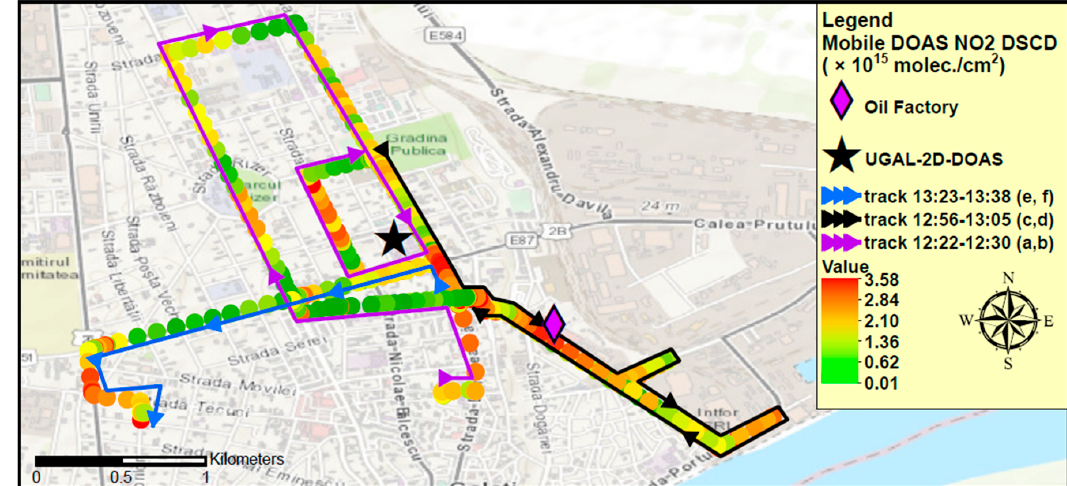
Figure 10. Map of spatial distribution of NO 2 DSCD (circles) retrieved using the car-DOAS system on 21 June 2017, during 12–14 LT. The trajectory of mobile DOAS system is shown by arrows of different colors, corresponding to time intervals when the UGAL-2D-DOAS system was scanning. The location of the UGAL-2-DOAS system and of the oil factory are also shown; note that the position of the steel factory, which is ~6 km away, cannot be included here for the sake of clarity of mobile DOAS resolution; (the map was created using ArcGIS